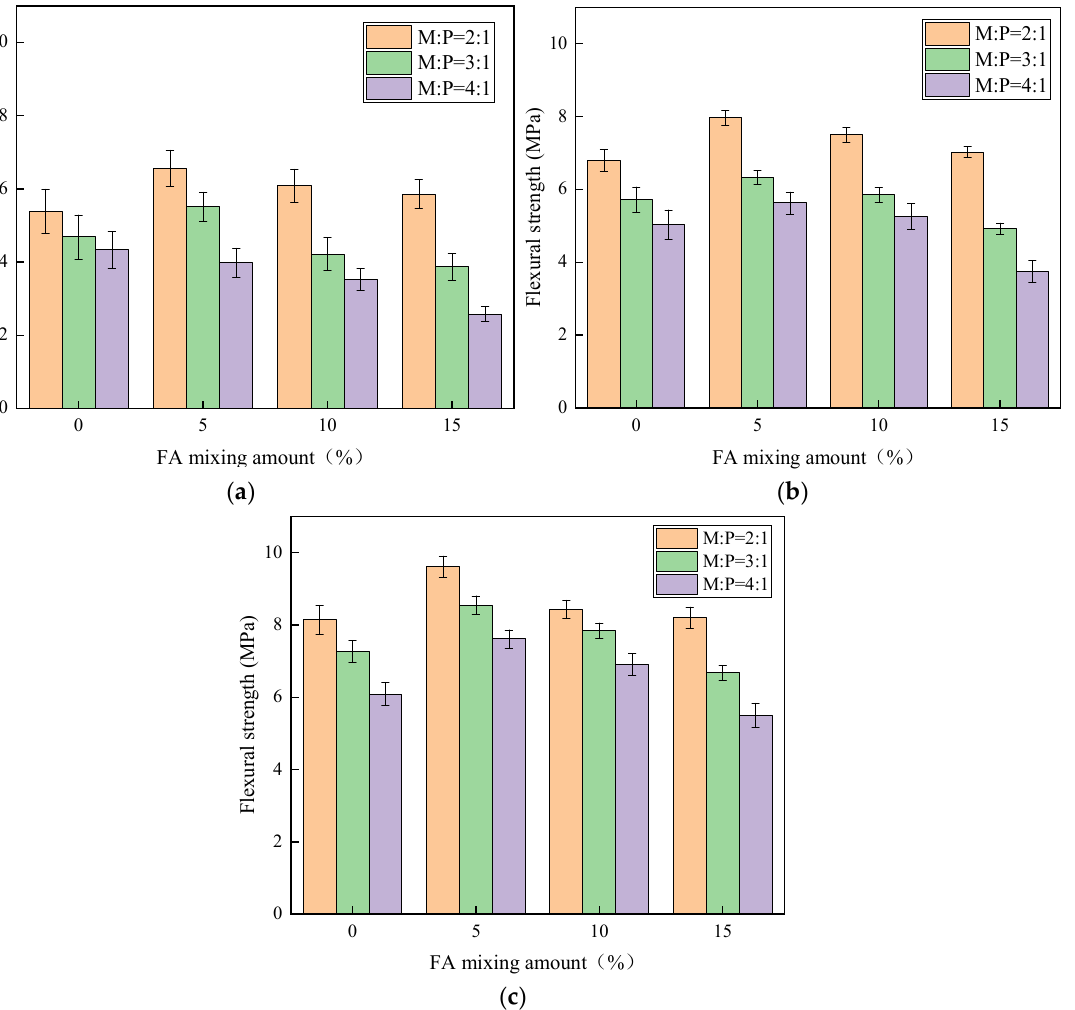
Figure 6. Flexural strength of potassium magnesium phosphate cement at different ages (unit: MPa): ( a ) Flexural strength of 1 d, ( b ) Flexural strength of 7 d, ( c ) Flexural strength of 28 d.